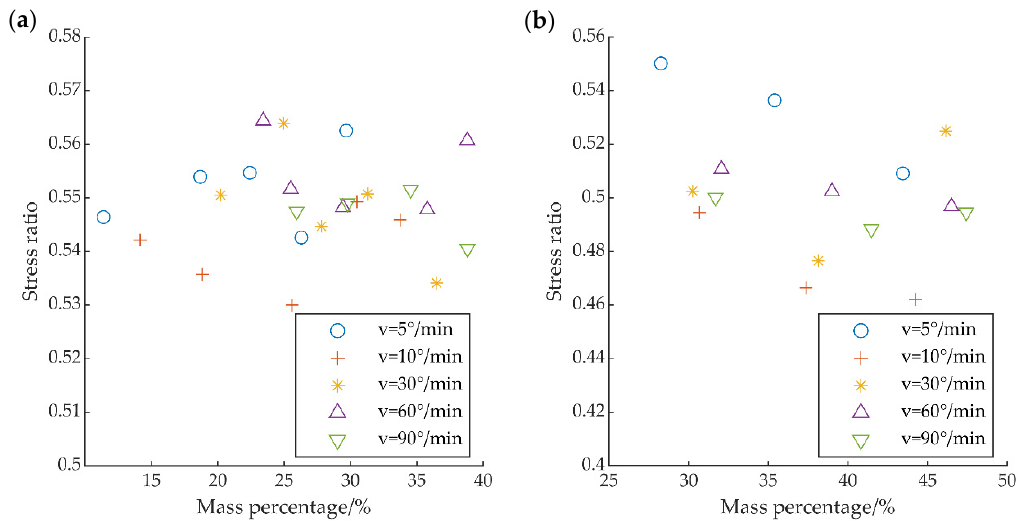
Figure 6. Relation of the stress ratio and the degree of particle breakage for different shear velocities: ( a ) quartz sand and ( b ) calcareous sand.